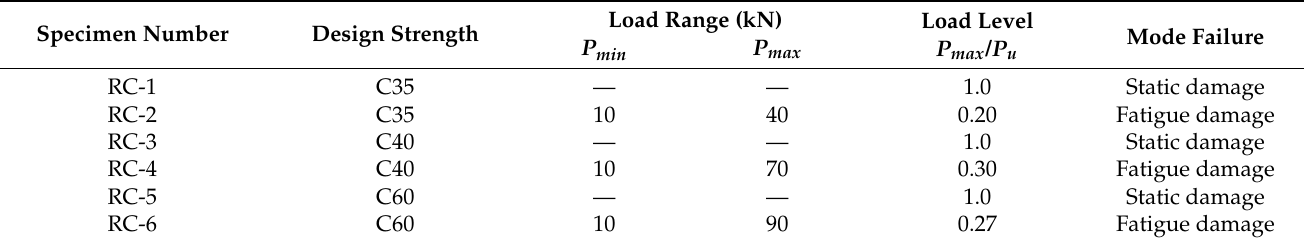
Table 2. Test design loading